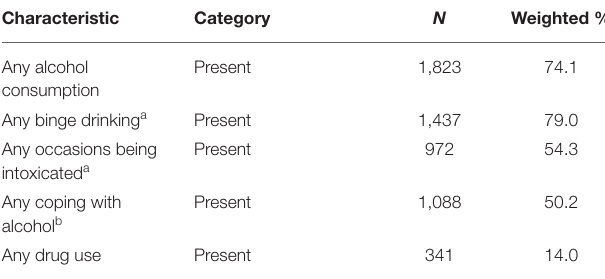
TABLE 2 | Characteristics of the study